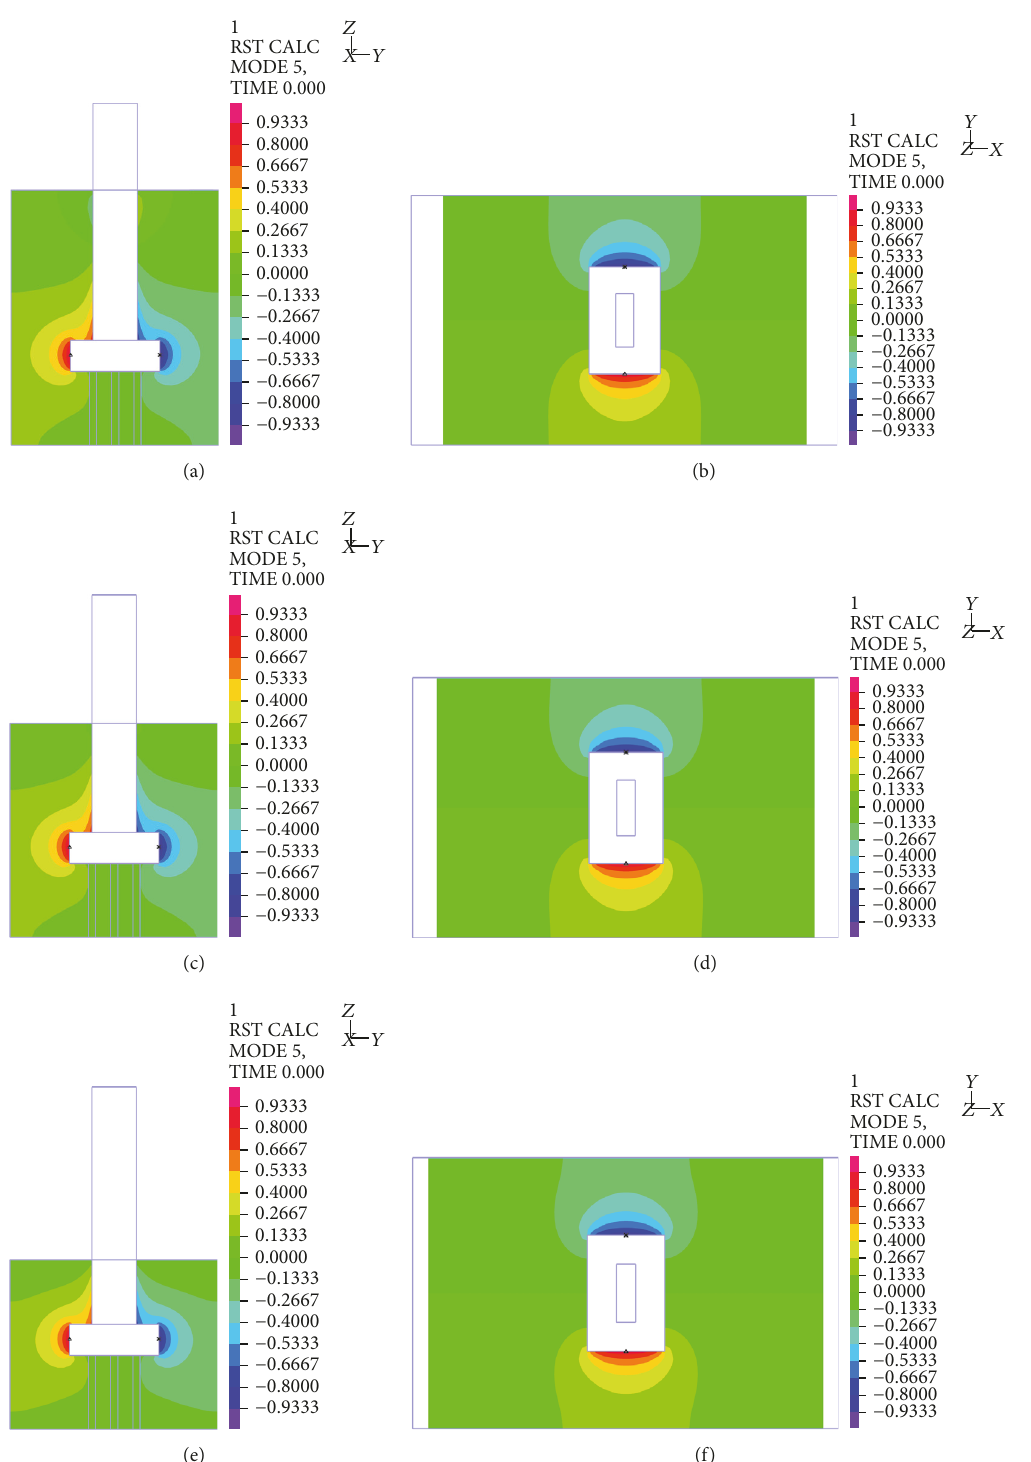
Figure 20: Nondimensional modal hydrodynamic pressures on the pier specimen without tip mass for the second mode vibration along 𝑦 -axis; profiles for a water level, 𝐻 𝑥 = 0 m and (b) 𝑧 = 0.65 m; profiles for a water level, 𝐻 w , of 1.8m along cutting planes: (a) w , of 1.5m along cutting planes: (c) 𝑥 = 0 m and (d) 𝑧 = 0.65 m; profiles for a water level, 𝐻 w , of 1.2 m along cutting planes: (e) 𝑥 = 0 m and (f) 𝑧 = 0.65